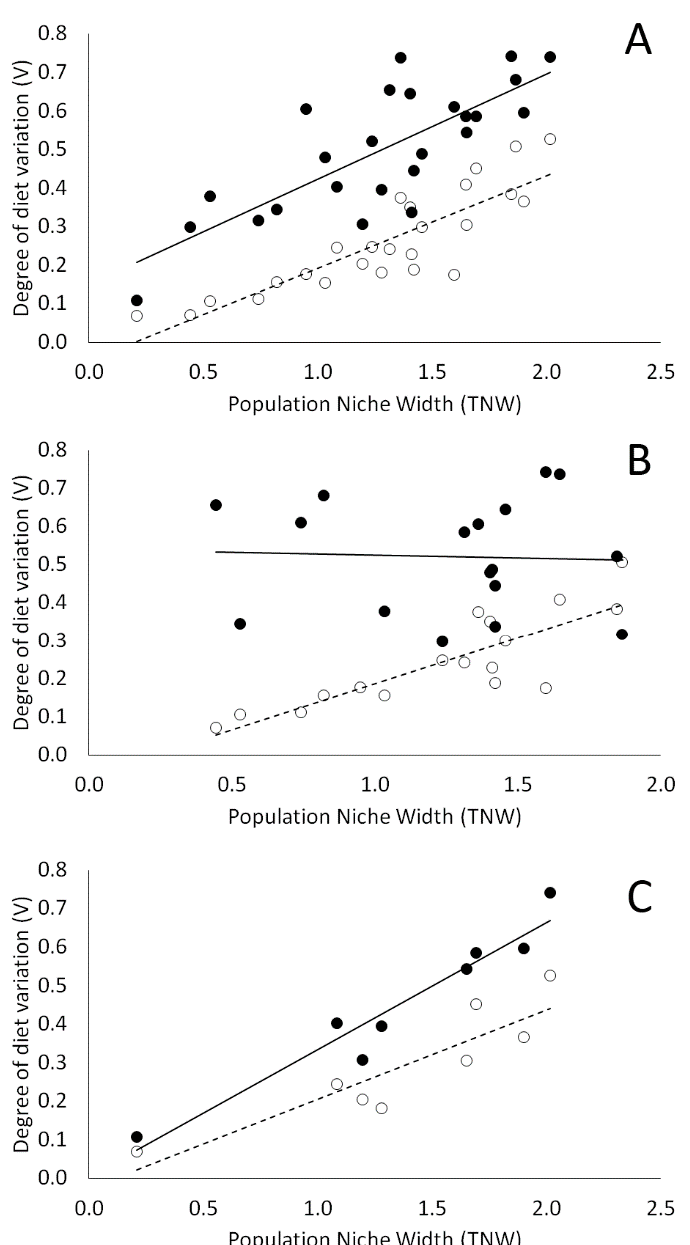
Figure 4. Correlation between diet variation among individuals (V) and the TNW for all the newt populations ( A ), for coexisting populations ( B ), and for population living in isolation ( C ). The observed values are shown with filled circles (and continue regression line). Empty circles (and the dotted regression line) indicate the expected trend under a null model in which diet variation arises solely by individuals randomly sampling a limited set of prey from a shared prey distribution.